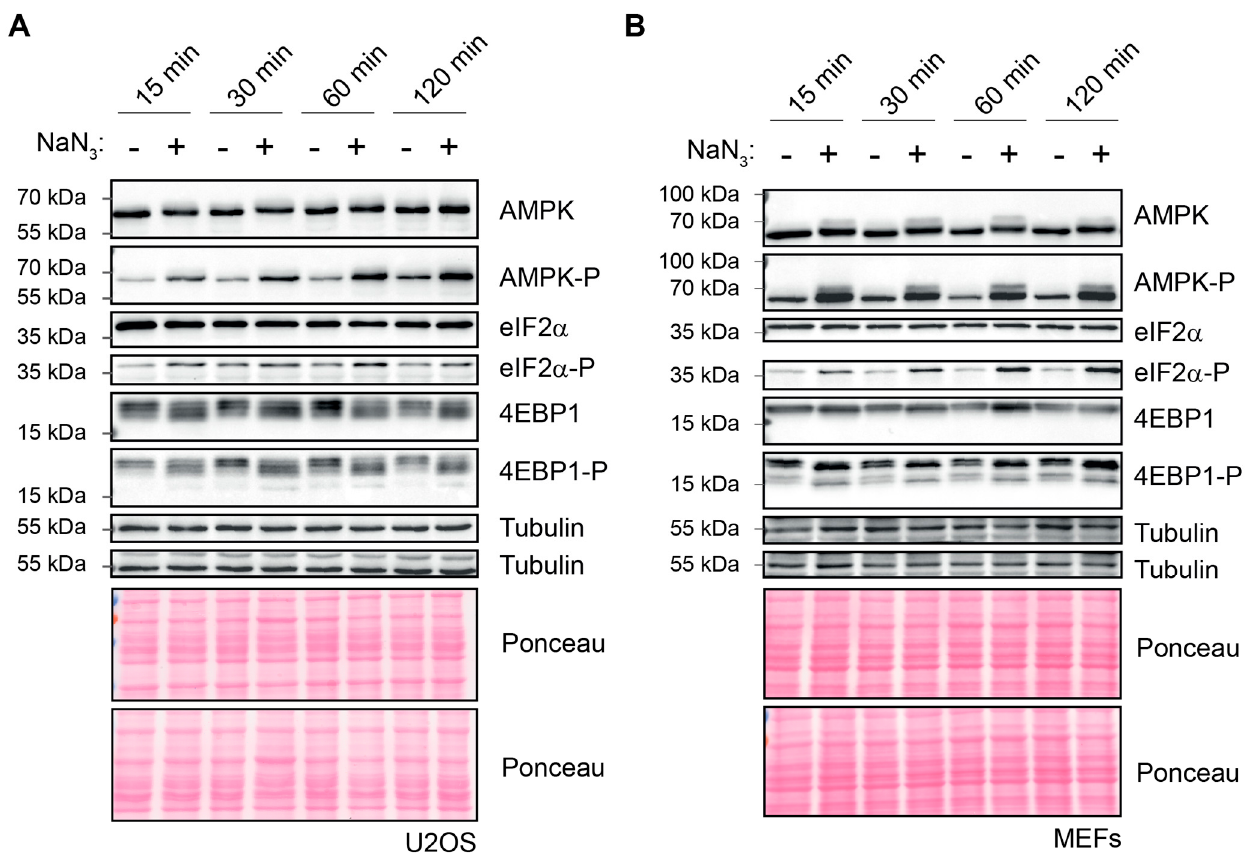
Figure 4. Altered cellular signaling in response to NaN 3 exposure. ( A ) U2OS cells were left untreated or subjected to NaN 3 stress (76 mM) of different durations. Cells were lysed, and the lysates were immunoblotted against the indicated proteins to investigate the activation of different signaling pathways. Tubulin and Ponceau stainings served as loading controls. ( B ) MEFs were cultivated under normal conditions or subjected to NaN 3 stress (76 mM) of different durations and prepared for WB the same as in A.